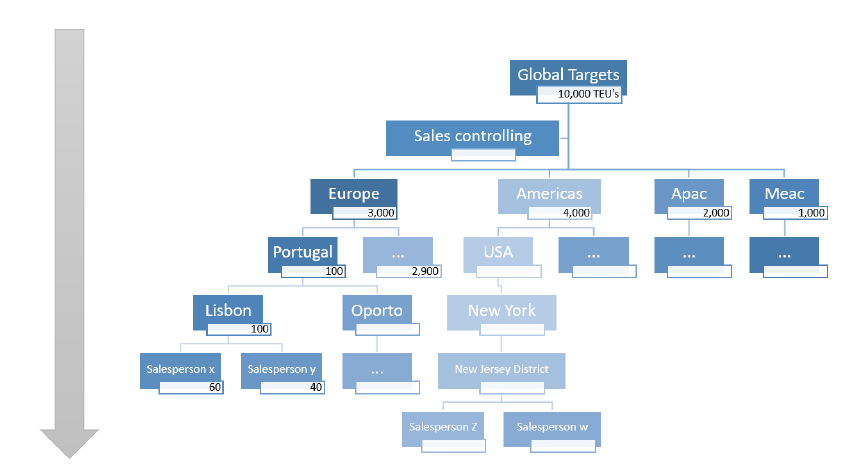
Figure 2. Target definition Top